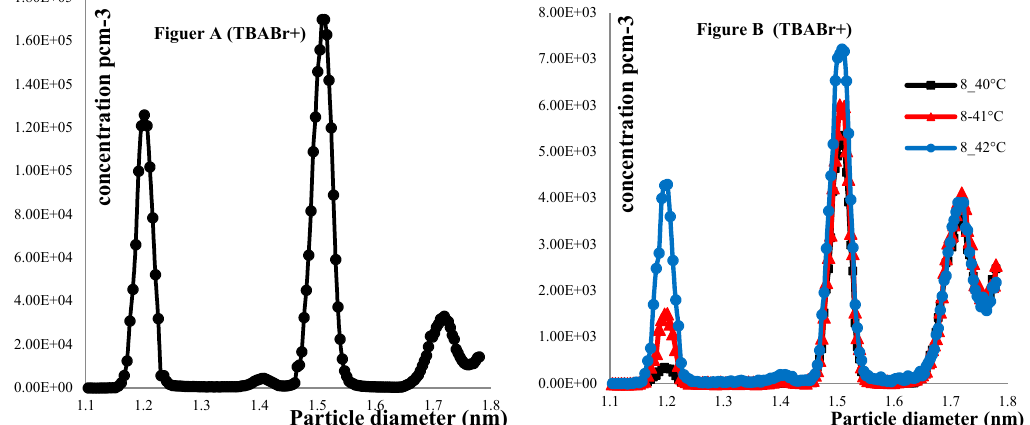
Figure 4. Mobility measurements of the tetraheptylammonium bromide with a DMA. Aerosol electrometer was in use in the results given in the Figure A (left panel). Variable T CPC (condenser saturator) was in use for the results given in the Figure B (right panel).